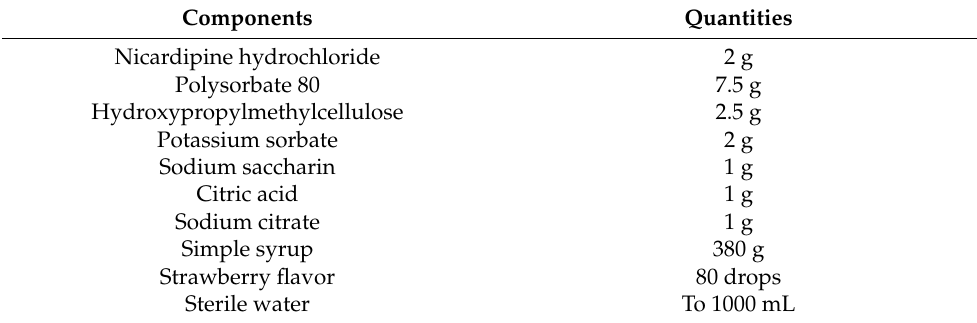
Table 4. Composition of nicardipine hydrochloride 2 mg/mL oral